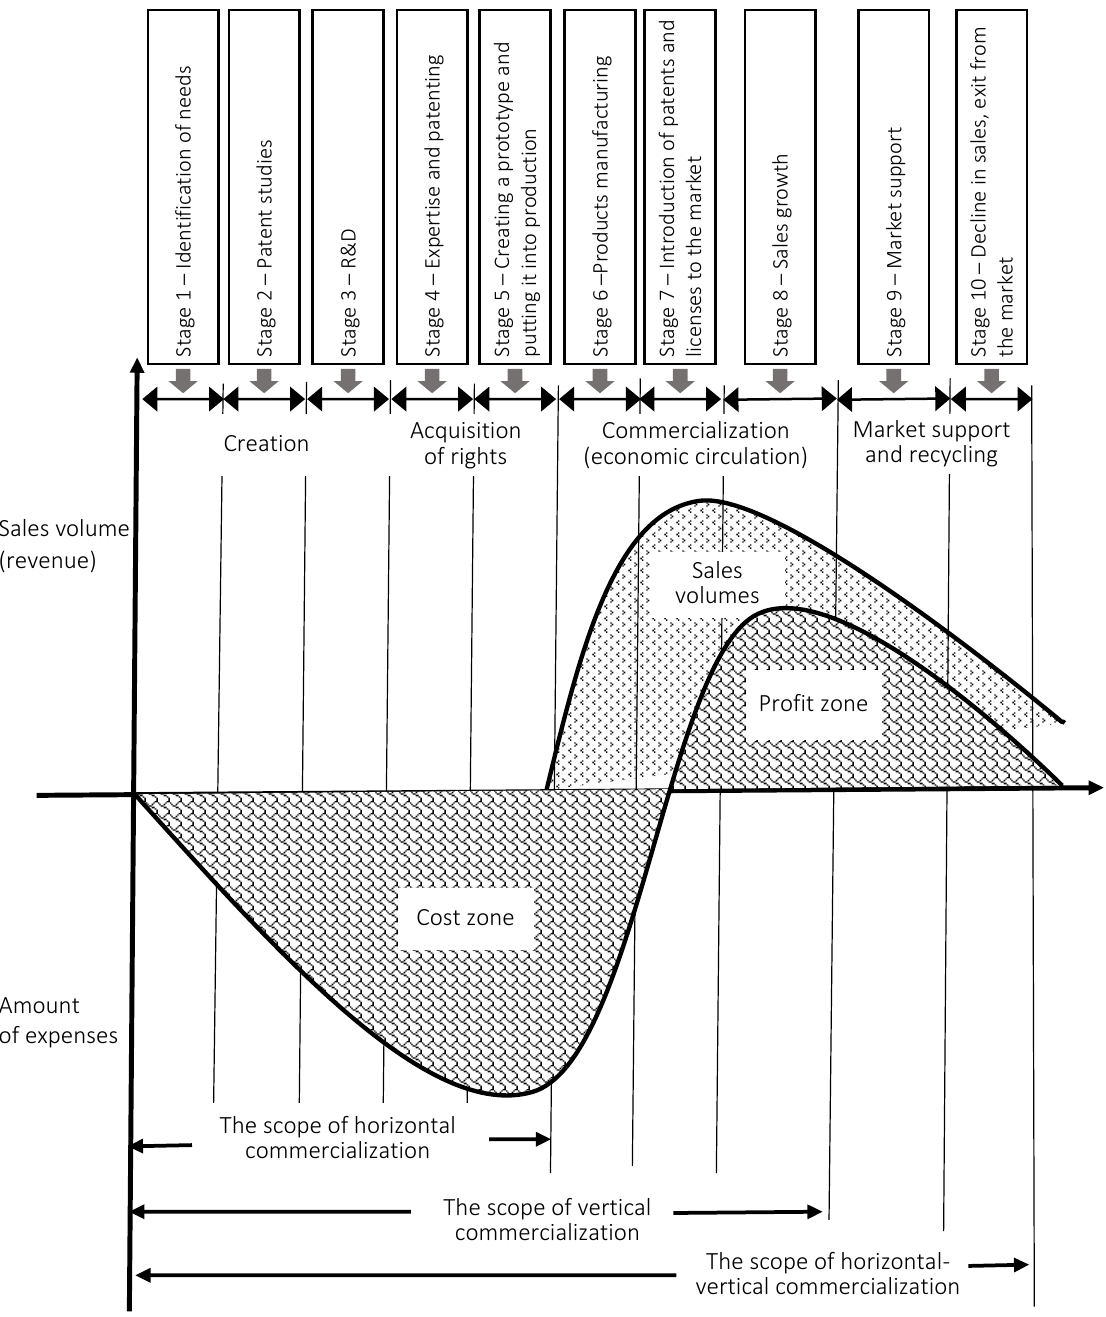
Figure 5. Market model of the life cycle of intellectual property (the market process of successive